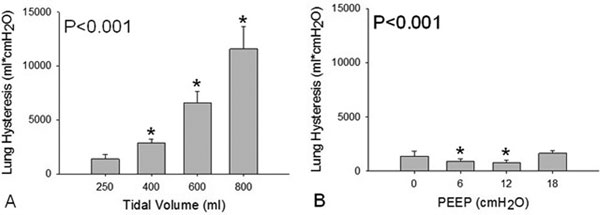
Lung hysteresis as a function of VT (A) and PEEP (B). *P < 0.05 versus VT 250 ml or PEEP 0 cmH2O (Holm-Sidak method).